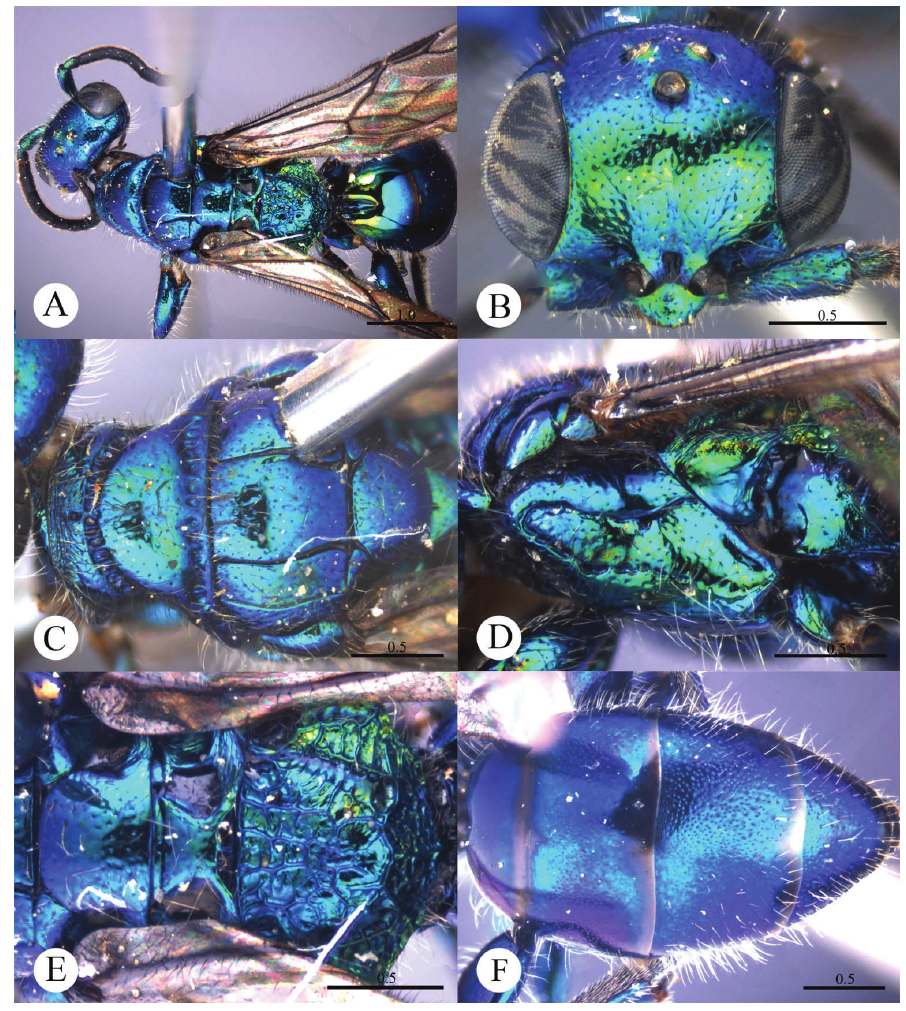
Plate 14. Cleptes tibetensis sp. n., holotype, male . A Habitus dorsal B Head anterior C Pronotum and mesoscutum dorsal D Mesopleuron and metapleuron lateral e Mesoscutellum, metanotum and propo- deum dorsal F Metasoma dorsal. Scale bars in